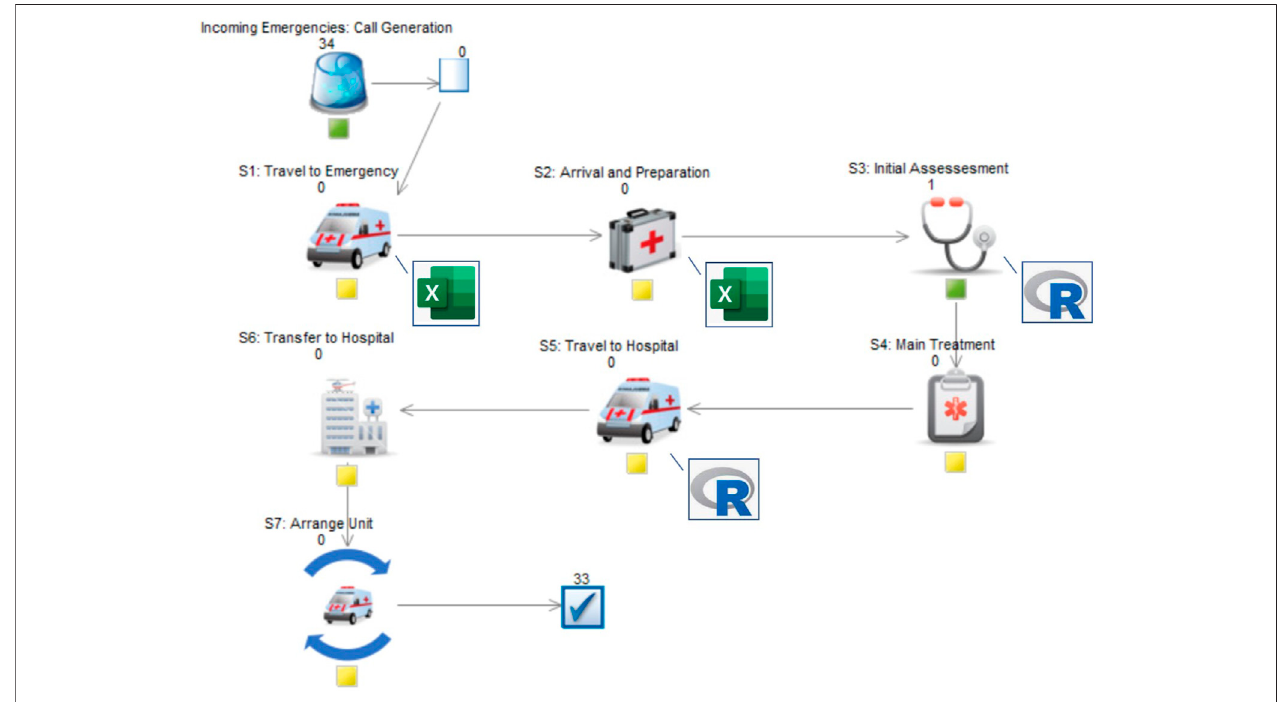
FIGURE 6 | Simulation during run time (SIMUL8 screenshot with